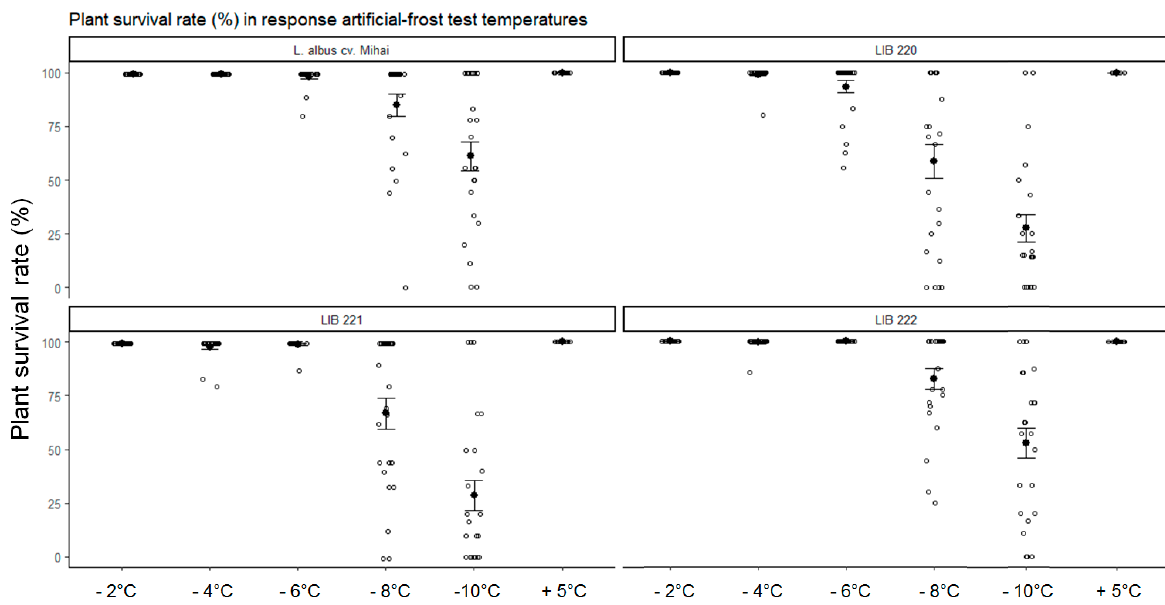
Figure 3. Assessment of four accessions, L. albus cv. Mihai and L. mutabilis LIB 220, LIB 221, and LIB 222 plant survival rate, in percentage, in response to artificial ‐ frost test temperatures ranging from low ( − 2 °C) to high ( − 10 °C) frost stress and with control samples at (+5 °C). Each dot represents the mean survival rate (%) of the 10 biological replicates, from one of the six containers, per genotype x temperature comparison, across all developmental phases.